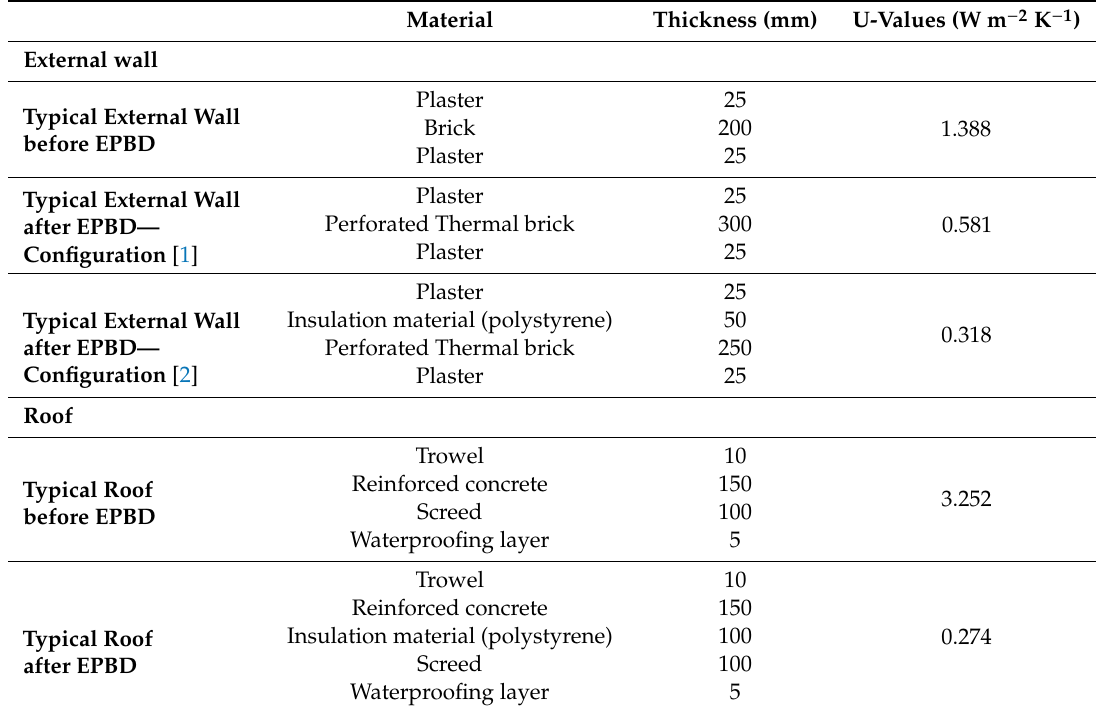
Table 2. Typical masonry and roof constructions in Cyprus, information derived from Fokaides et al.